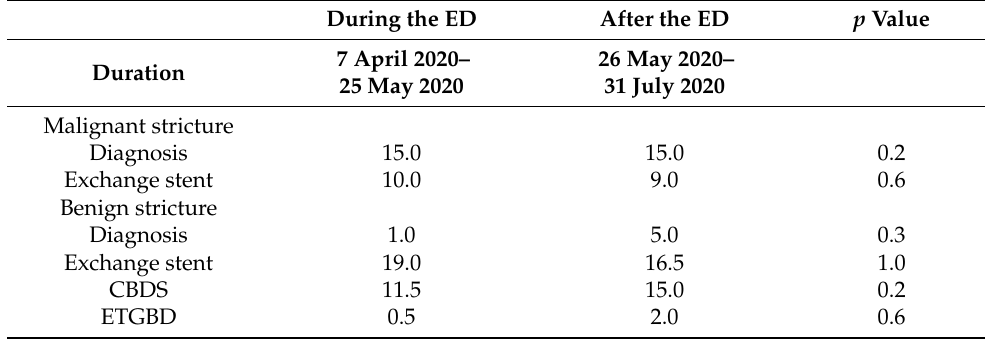
Table 3. The breakdown of ERCP during and post emergency declaration (monthly average). During the ED After the ED p Value Duration Malignant